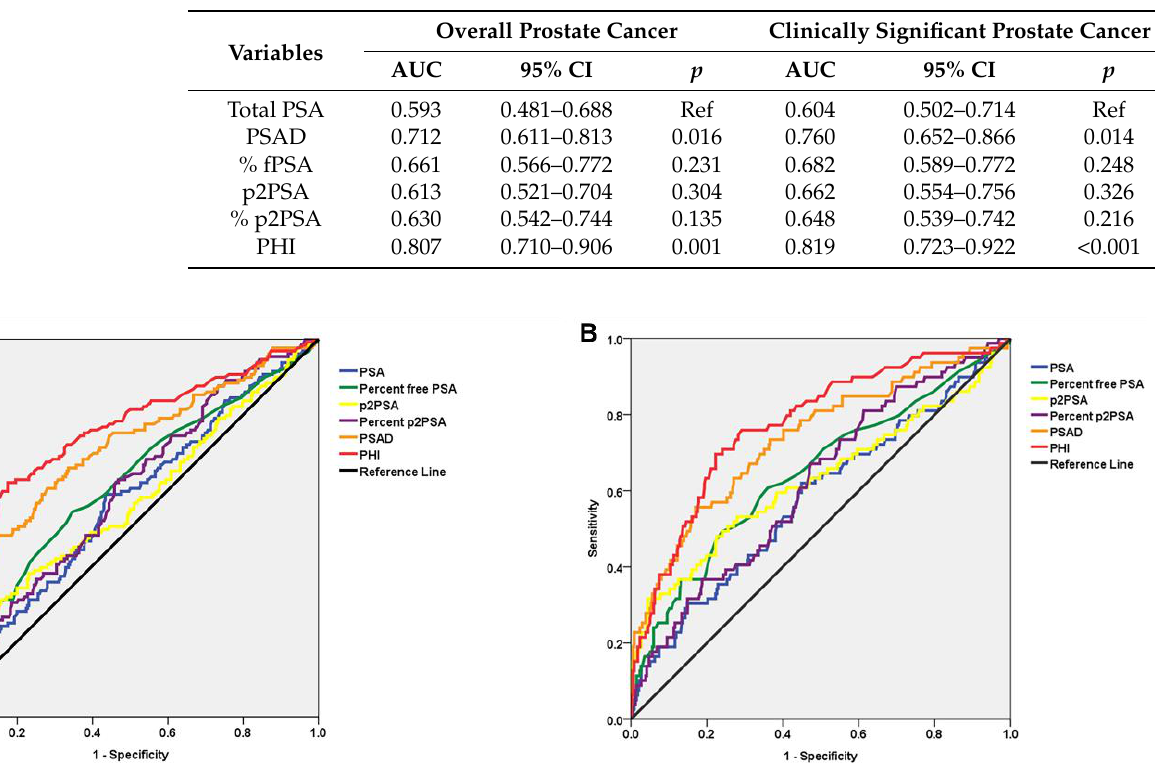
Figure 2. Pathologic outcomes of PI-RADS v2 score-3 lesions, as assessed by cognitive, TRUS- targeted cores.